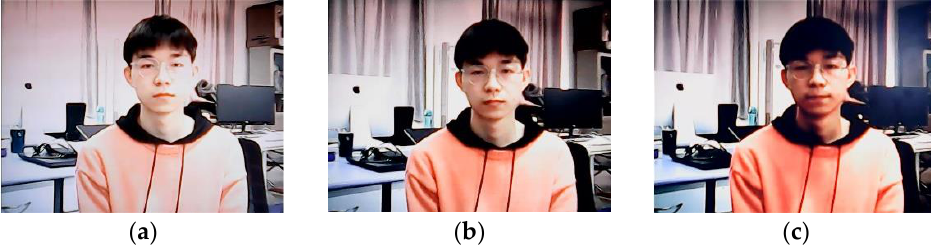
Figure 6. Examples of video faces in self-built dataset. ( a ) High light. ( b ) Normal light. ( c ) Dark light.